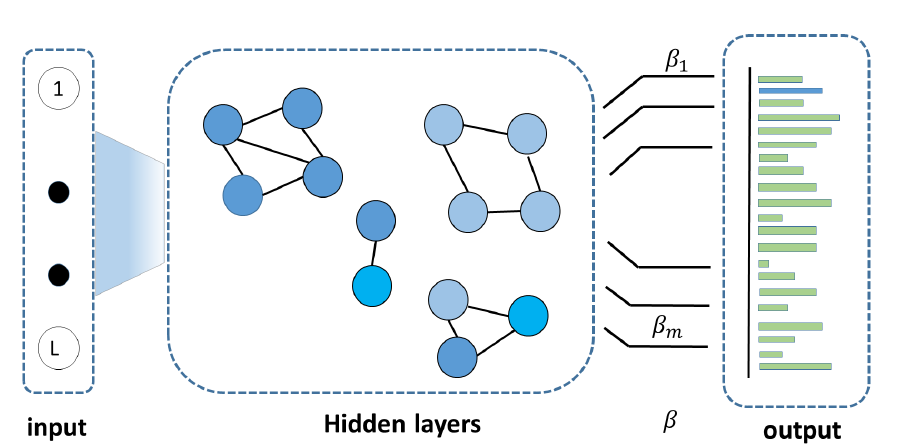
Figure 5. Shows the architecture of PKELM